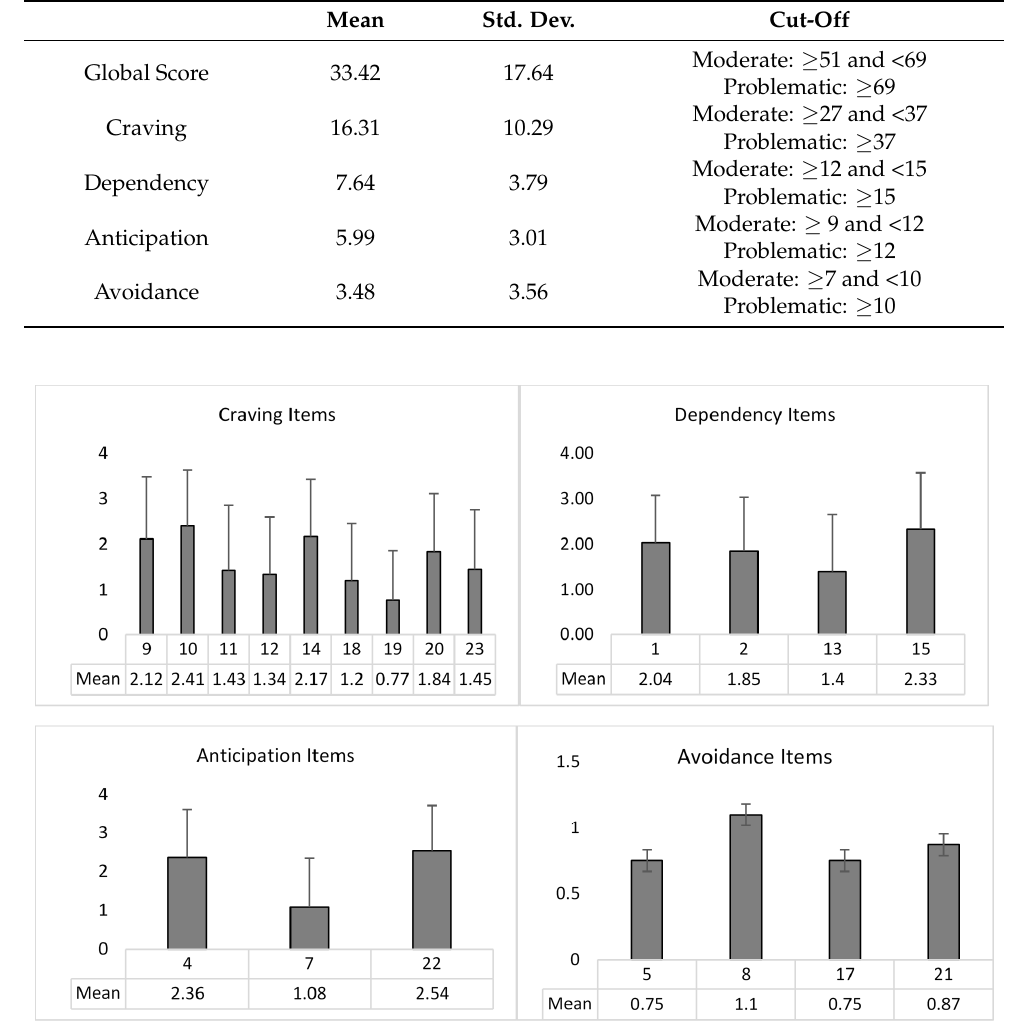
Table 6. Mean, Standard Deviation, and Cut-Offs of the BWAQ global score and subscales.